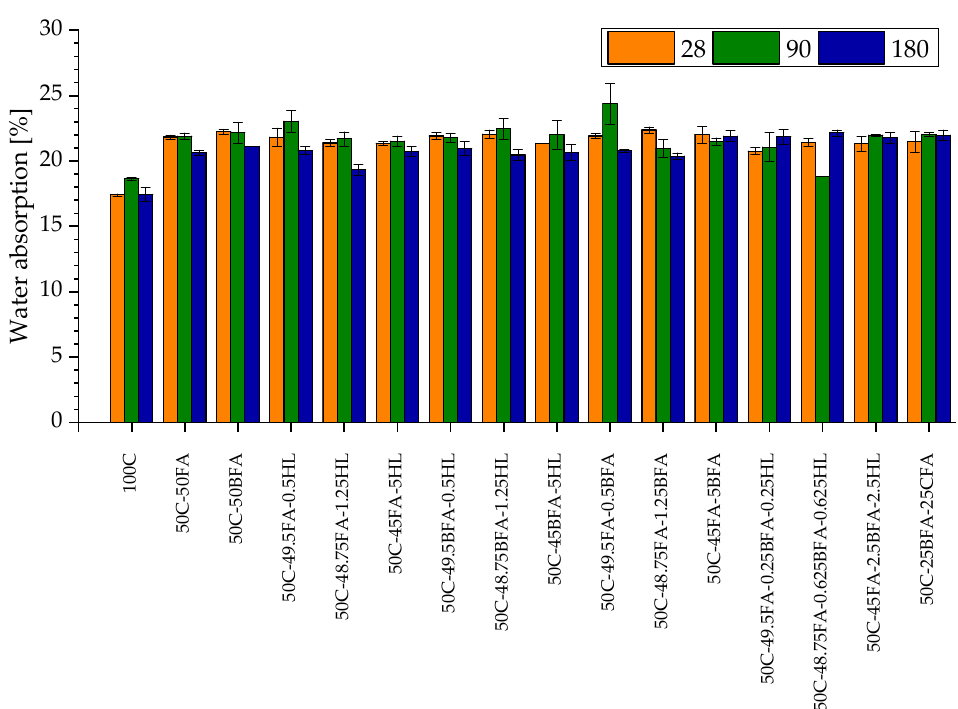
Figure 7. Open porosity of mortar samples determined by water absorption for 28, 90, and 180 days of curing.